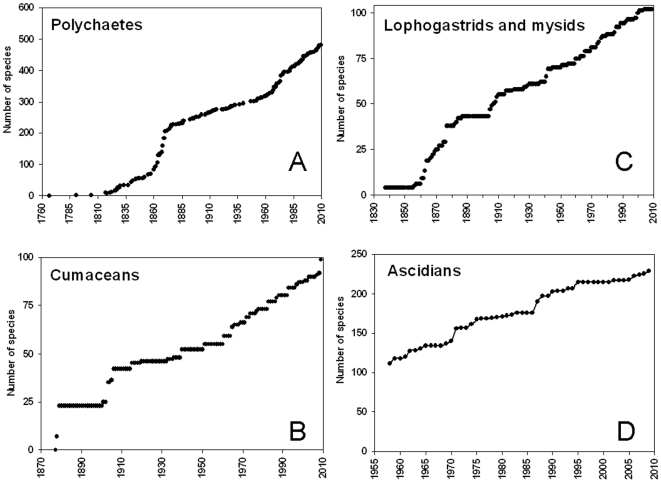
Cumulative numbers of species discovered (described or first recorded) over time in the Mediterranean Sea.(A) polychaetes, (B) cumaceans, (C) lophogastrids and mysids, and (D) ascidians (File S2).